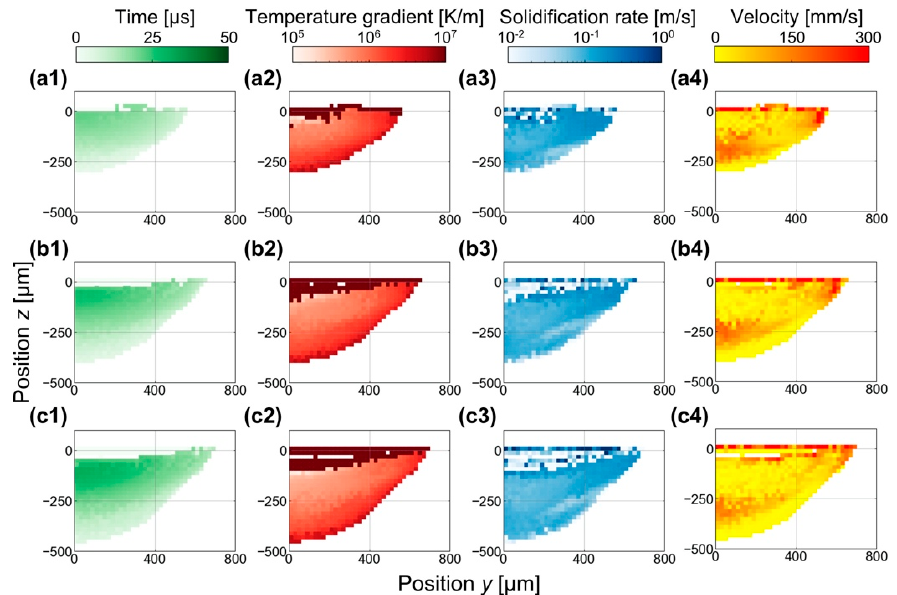
Figure 8. CtFD simulated cross-sectional melt pools of 316L SS colored by ( a1 – c1 ) a solidification time, ( a2 – c2 ) a temperature gradient, G , ( a3 – c3 ) a solidification rate, R , and ( a4 – c4 ) a flow velocity, U . The beam powers were ( a1 – a4 ) P = 600 W, ( b1 – b4 ) P = 900 W, and ( c1 – c4 ) P = 1200 W.